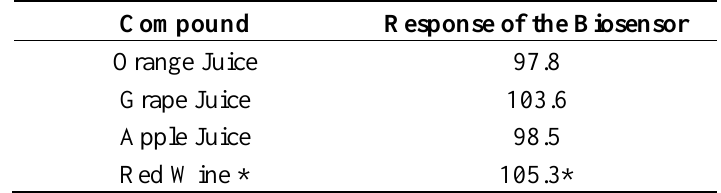
Table 4. Interference of coloured solution; in the presence of 1% (v/v) ethanol, on the response to ethanol of AOX/PANI